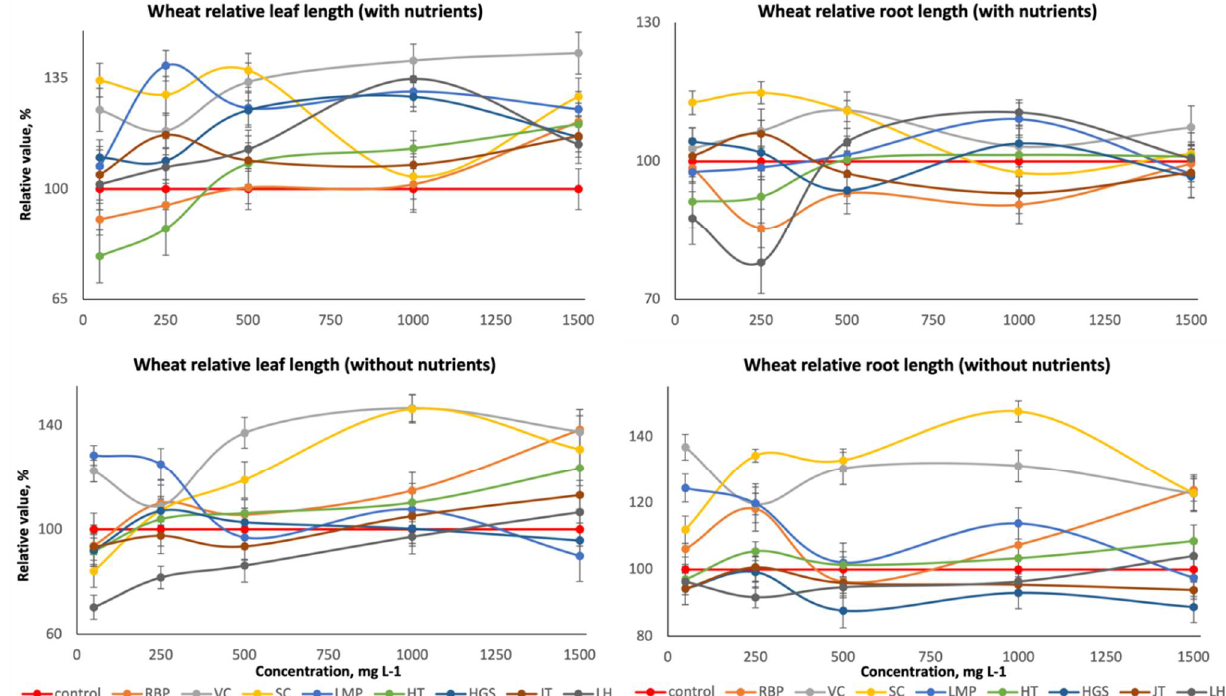
Figure 5. Relative changes in winter wheat ( Triticum aestivum ) shoot and root length over a concentration range of HS solutions of different origins, with and without added nutrient solution. RBP = raised bog peat, VC = vermicompost, SC = soil compost, LMP = low moor peat, HT = Humin Tech potassium humate, HGS = Humic Growth Solutions potassium humate, JT = Jin Tai FA, LH = Lignohumate HS.